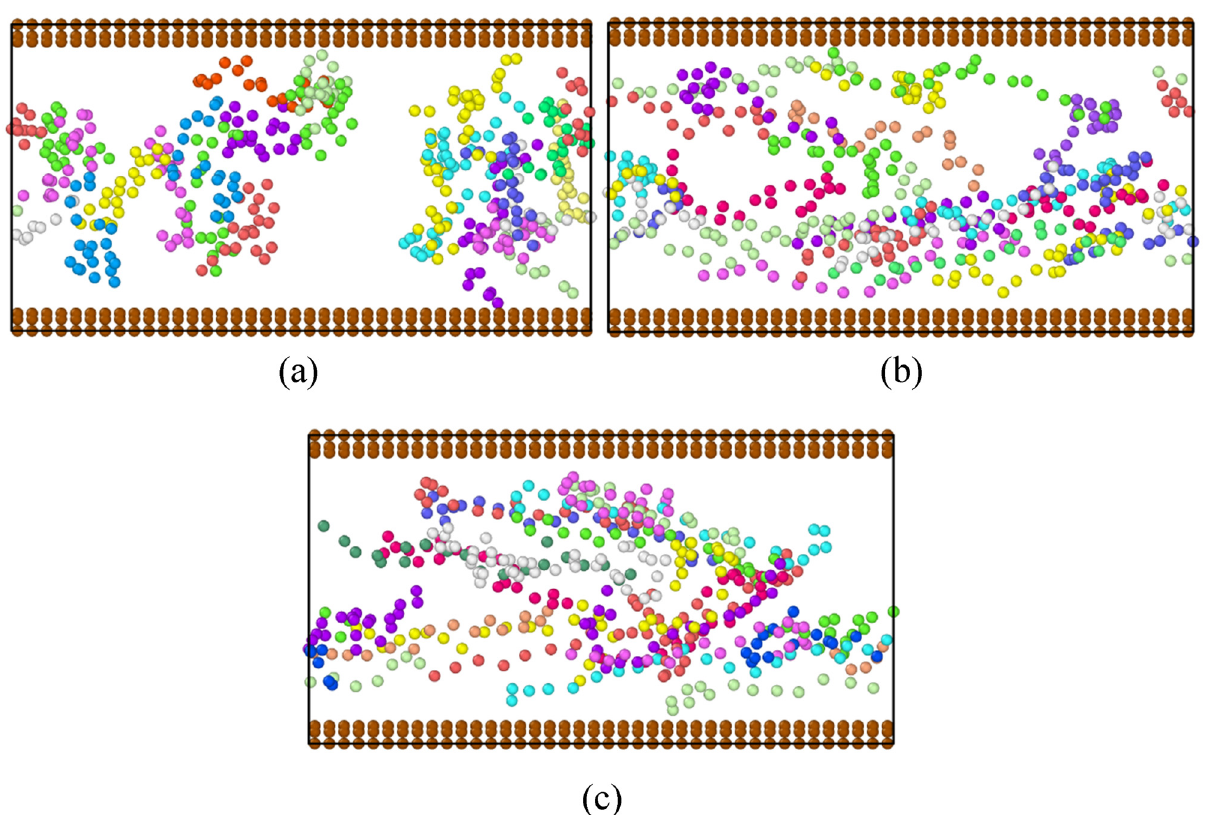
Figure 13: Snapshots for wormlike chains with = λ 0.5 peff for varying values of the driving force at the last time step: ( a ) f = 0, ( b ) f = 0.1, and ( c ) f =